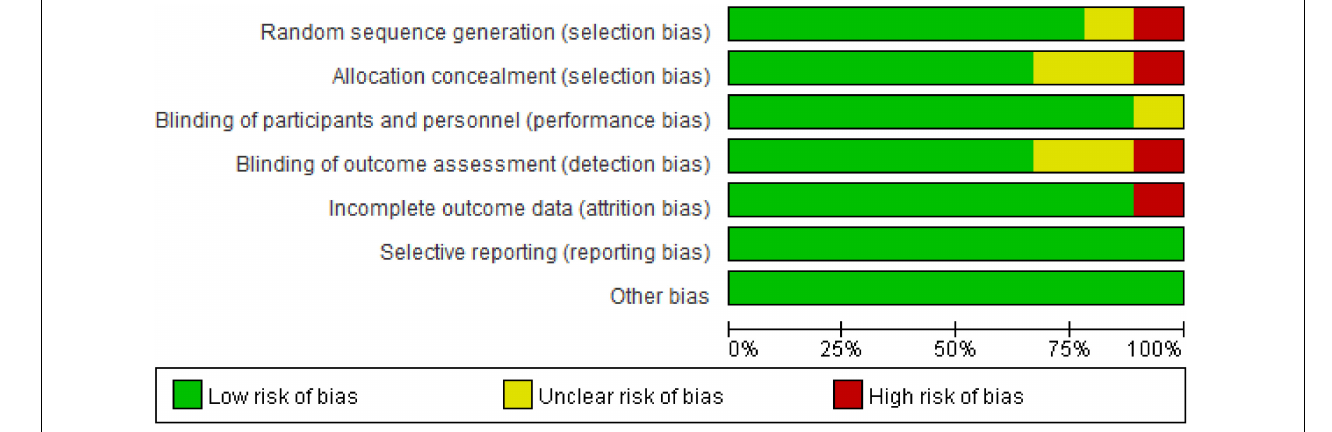
FIGURE 6 | Risk of bias in included